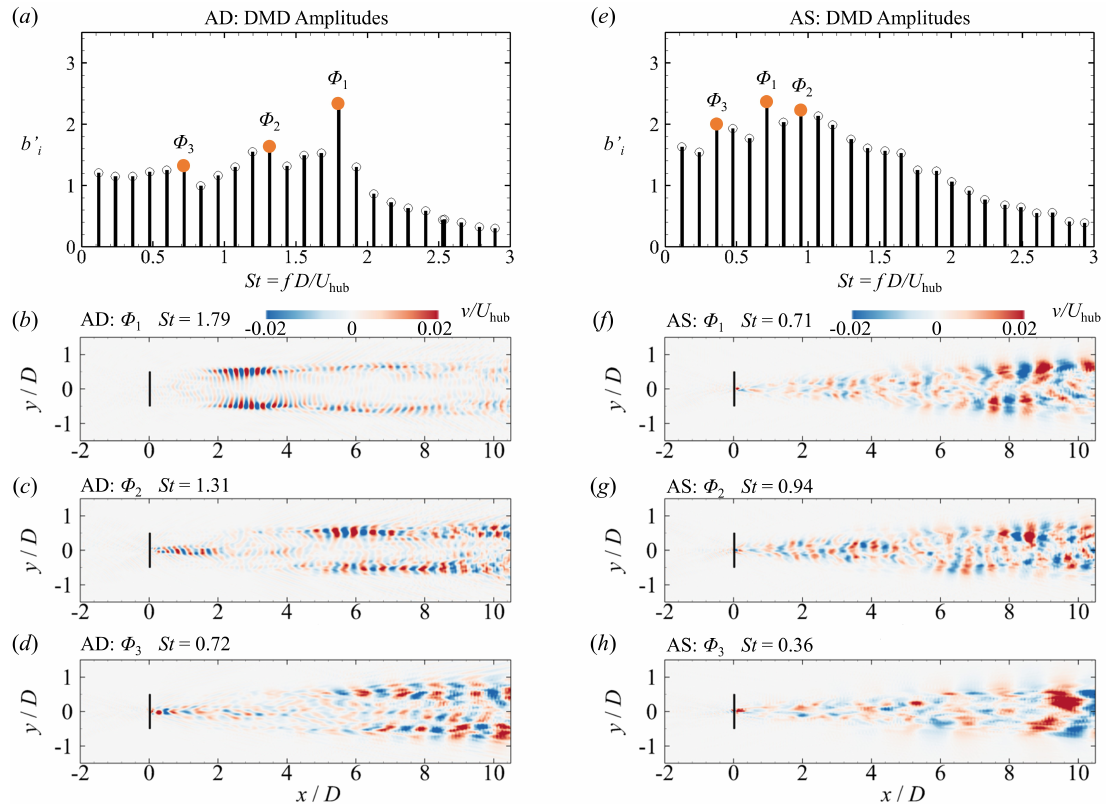
Figure 4. Uniform inflow: Dynamic mode decomposition (DMD) analysis of the velocity field on the horizontal plane at the hub height ( z = z hub ). ( a , e ) the eigenvalue-weighted amplitudes of the DMD modes for the AD and the AS models; ( b – d ) the largest three DMD modes ordered by amplitude of AD; ( f – h ) the largest three DMD modes ordered by amplitude of AS. DMD modes are shown with the spanwise velocity